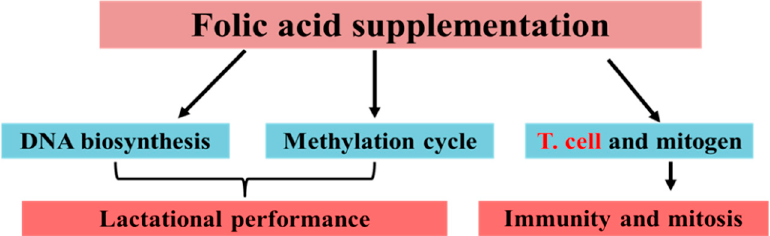
Figure 1. Folic acid regulates the remethylation cycle of methionine, DNA biosynthesis, and T cells.